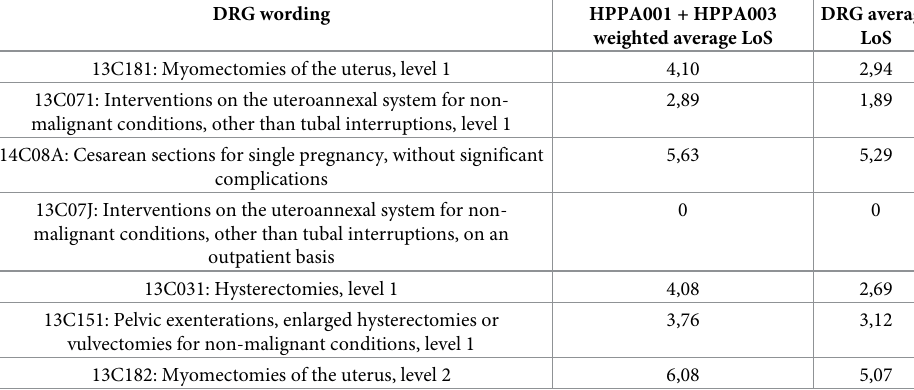
Table 2. Main DRG according to HPPA001 and HPPA003 medical acts.